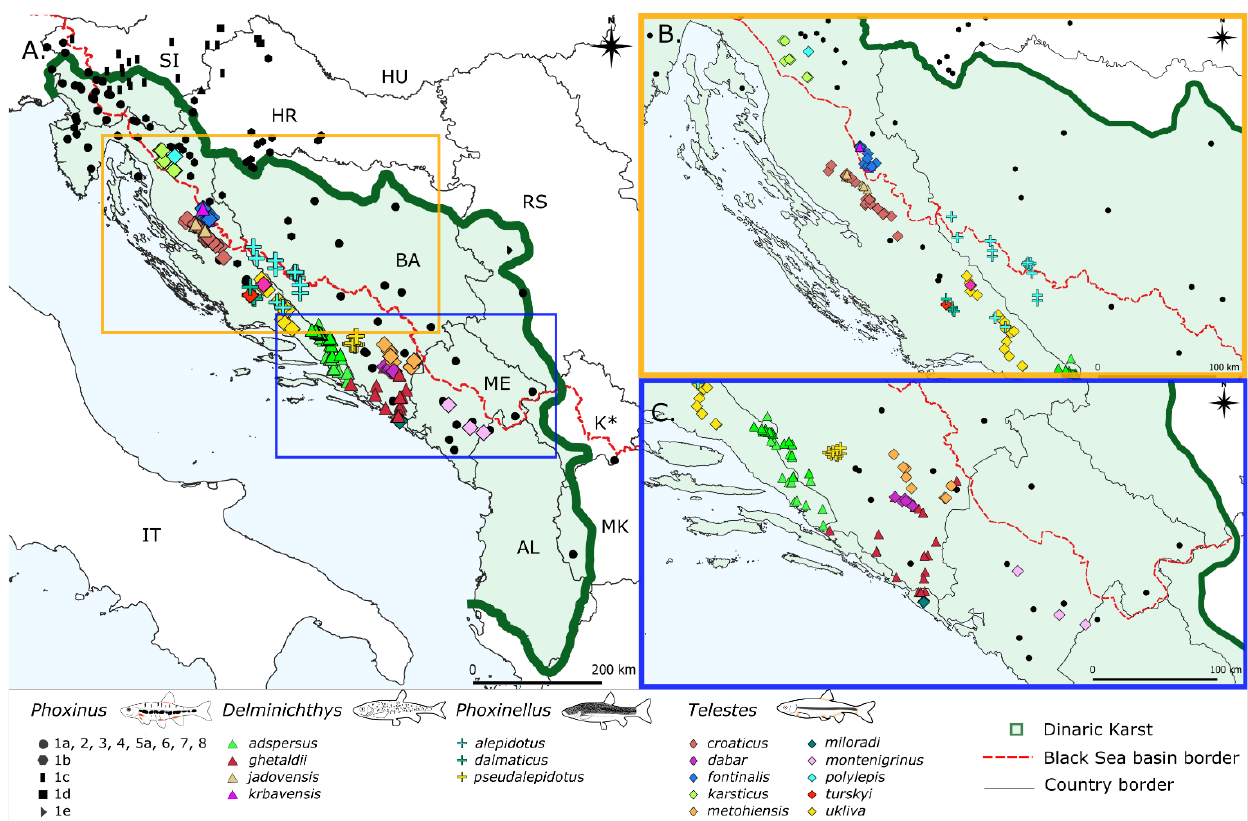
Figure 1. Distribution data of four fish genera Phoxinus , Delminichthys , Phoxinellus and Telestes in Dinaric Karst. Phoxinus is shown in black, while Delminichthys , Phoxinellus and Telestes are presented in color. ( A ) Overview of Dinaric Karst ( B ) Enlargement of the northern part of Dinaric Karst (framed in orange) ( C ) Enlargement of the southern part of Dinaric Karst (framed in blue). Phoxinus sub-lineages 1a – 1e are represented with symbols shown in the key.